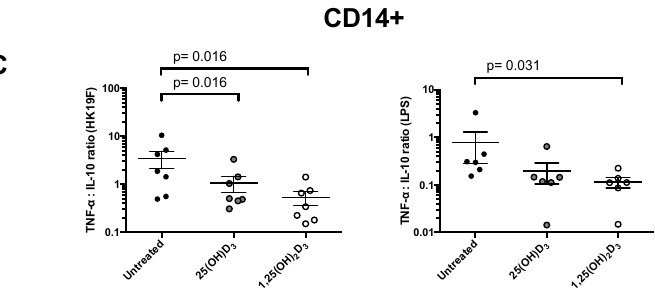
Figure 3. Effect of 1,25(OH) 2 D 3 on PBMCs and CD14+ monocytes cytokine profile. PBMCs pre-treated with 1,25(OH) 2 D 3 or 25(OH)D 3 for 4 h and stimulated with ( A ) HK19F or ( B ) LPS. Data shown represents the mean ± SEM, ( n = 13); and ( C ) CD14+ monocytes pre-treated with 1,25(OH) 2 D 3 or 25(OH)D 3 for 4 h and stimulated with HK19F or LPS. Data shown represents the mean ± SEM ( n = 7). Treatment groups were compared with untreated-stimulated groups only, with significance calculated using a paired Wilcoxon sign-rank test.